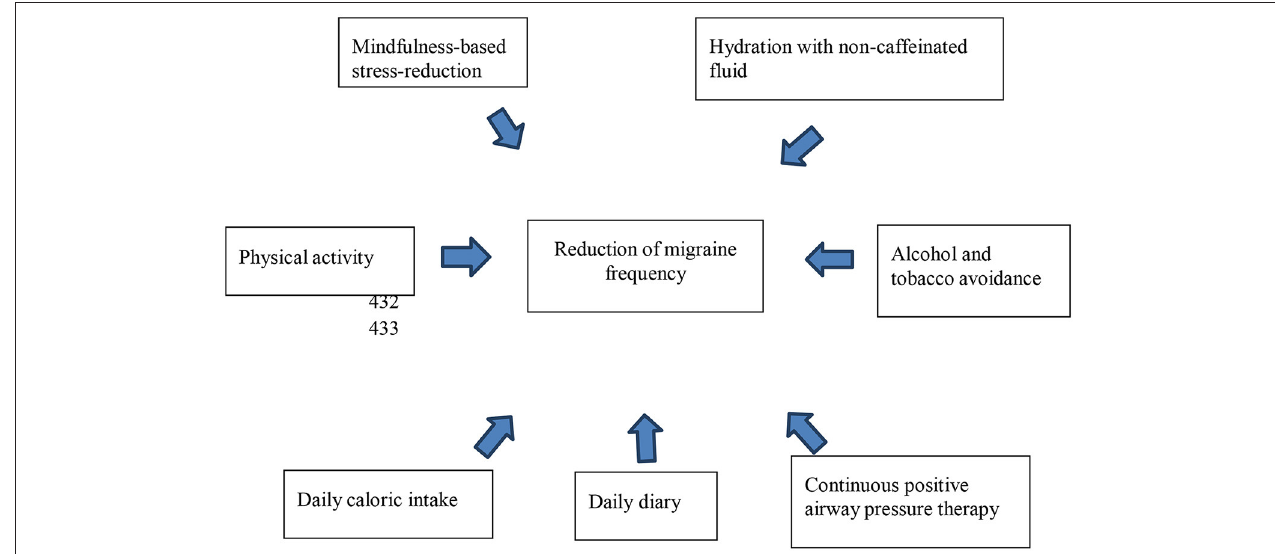
FIGURE 1 | Lifestyle modification in migraine